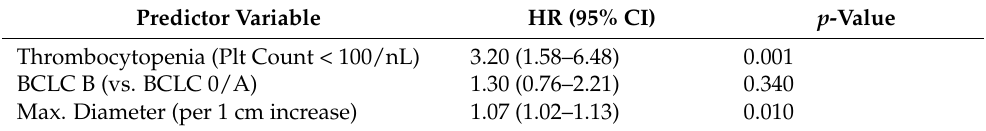
Figure A1. Schematic detailing the postoperative outcomes of the 128 patients included in the study. Table A1. Overall survival analysed by multiple Cox regression (plt count: binary variable).